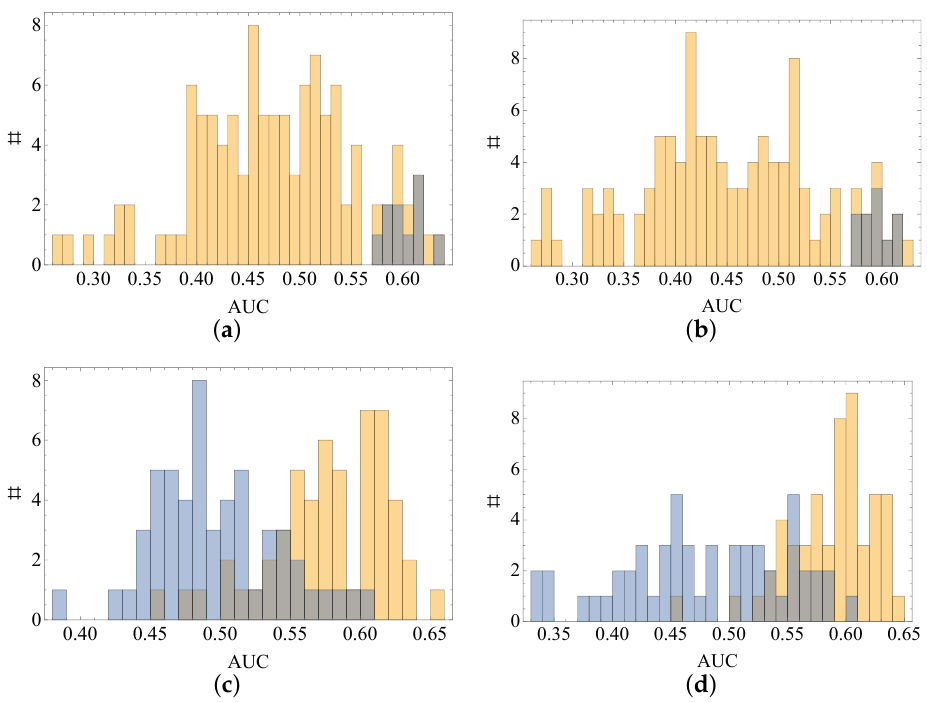
Figure 4. Histograms for the feature selection of the best performing feature pair in ( a , b ) and triplets in ( c , d ); orange bars refer to Figure 3b, while for the blue ones, see Figure